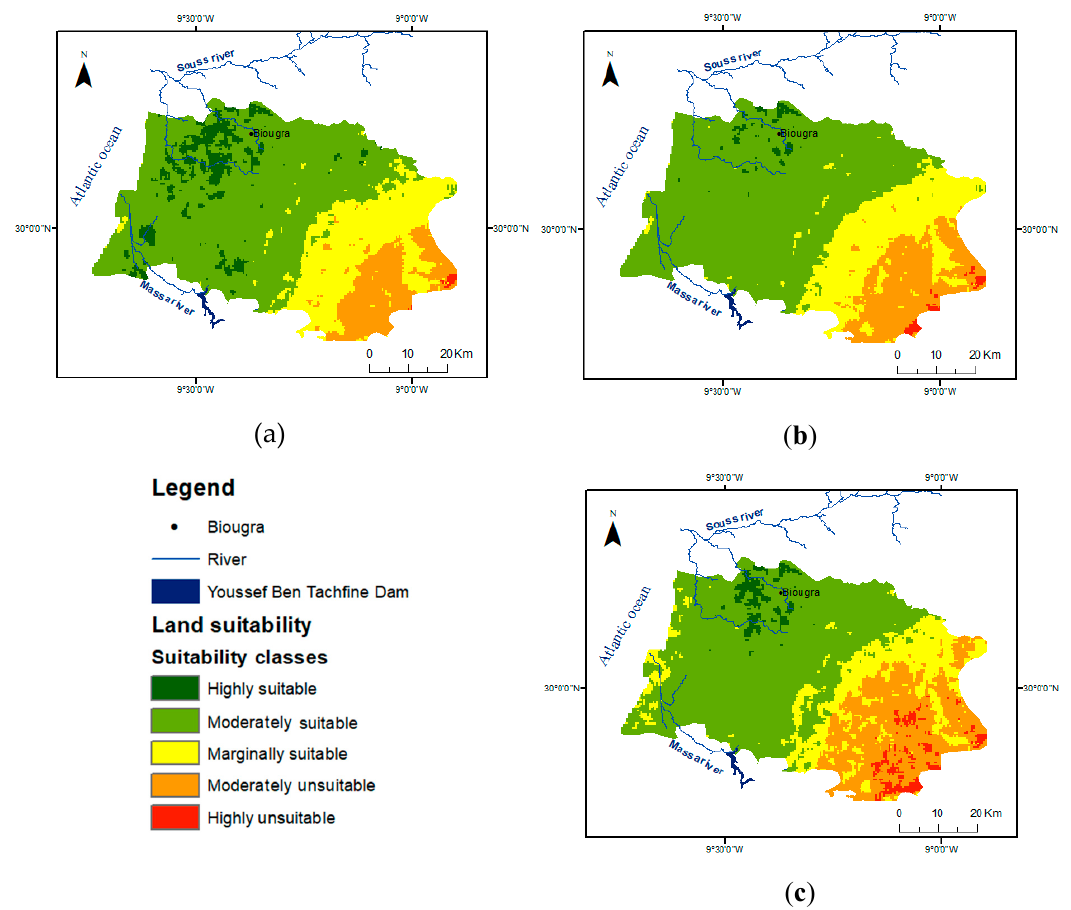
Figure 5. Land suitability map ( a ) baseline, ( b ) under the RCP4.5 scenario, and ( c ) under the RCP 8.5 scenario.